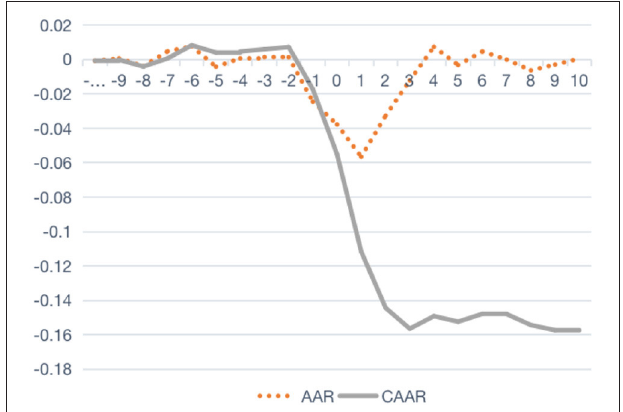
FIGURE 2 | AAR and CAAR of the competitive firm during the incident period.